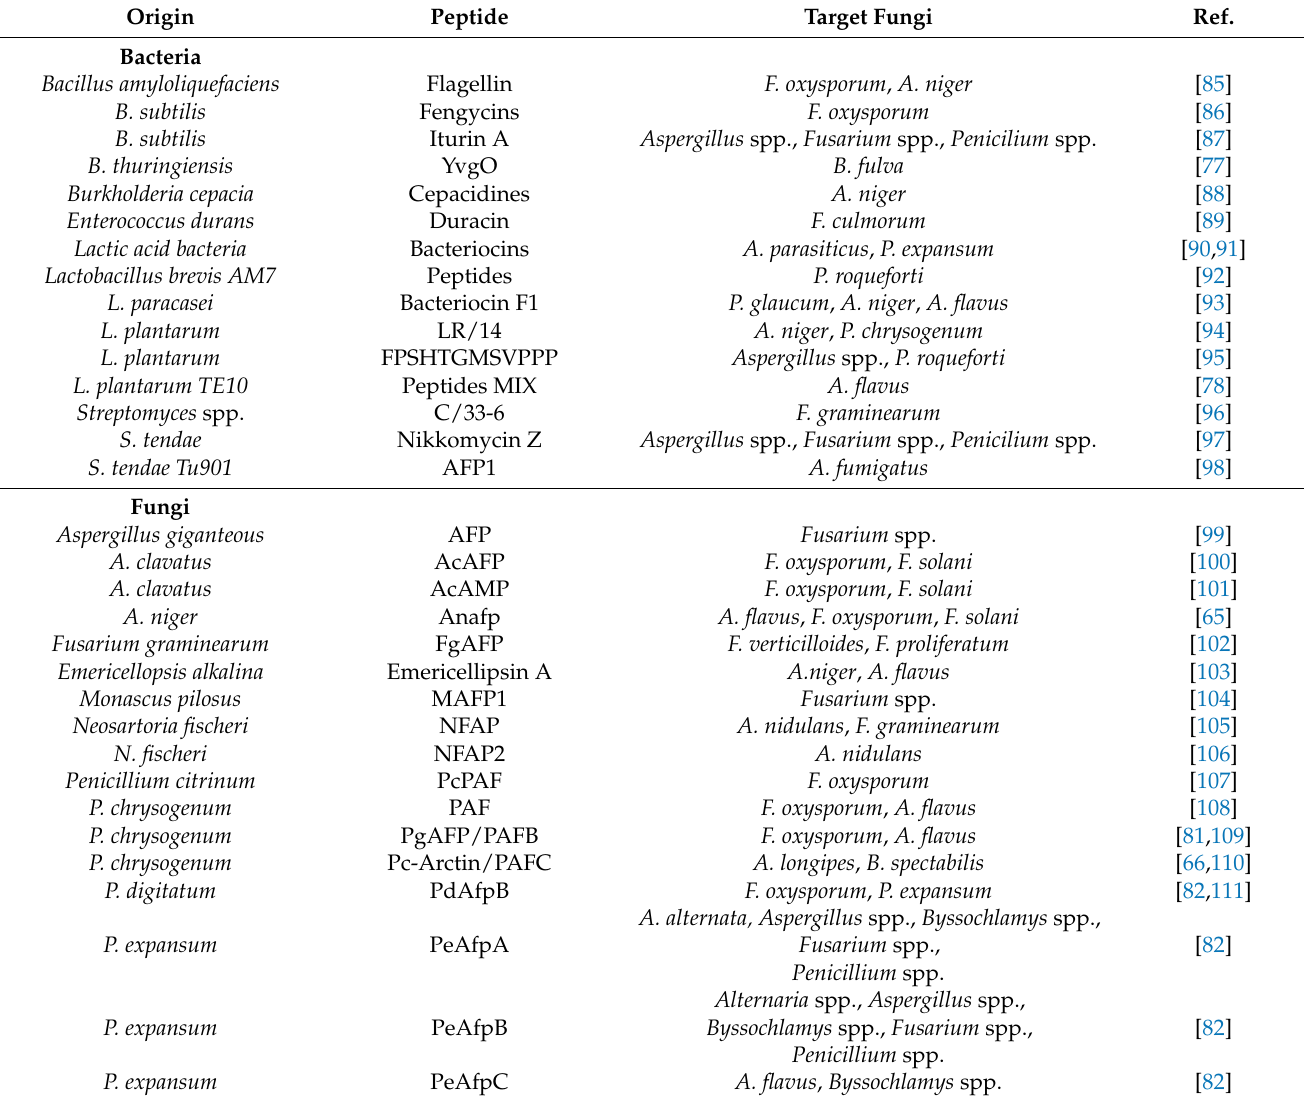
Table 1. Microbial antifungal proteins and peptides with activity against mycotoxin-producing fungi. Origin Peptide Target Fungi